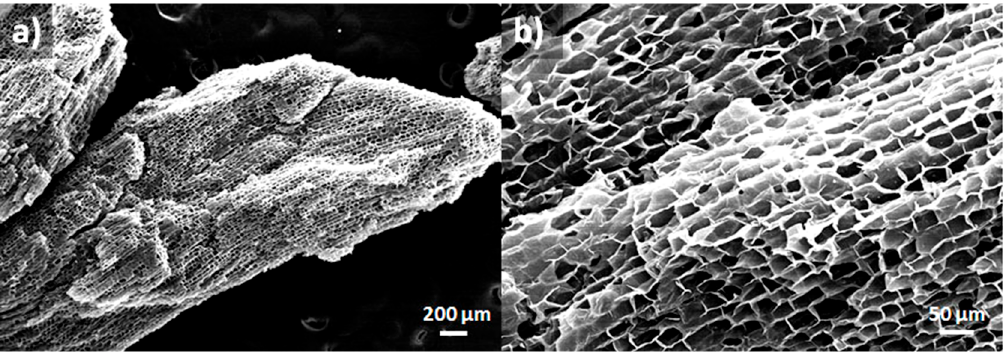
Figure 2. Scanning electron microscope (SEM) micrographs at two different magnifications showing ( a , b ) the microstructure of the cork granules.